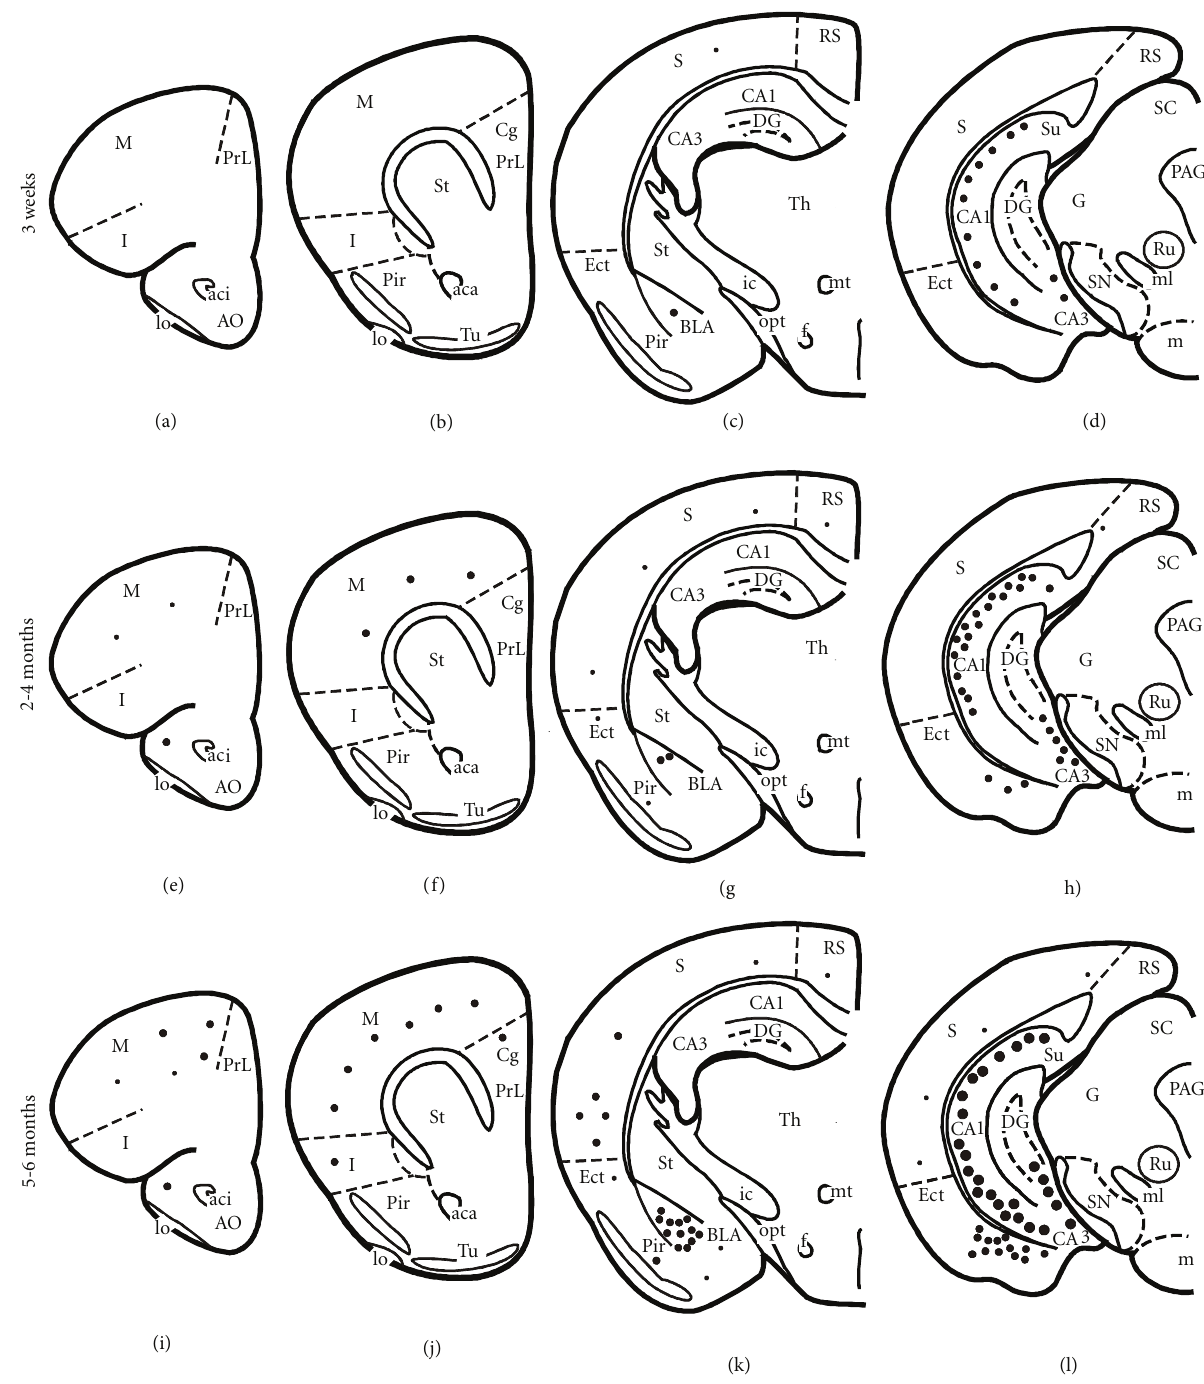
Figure 7: Schematic drawings showing the distribution of AT8-ir neurons in transcardially fixed 3-week, 3-, and 6-month-old 3xTg-AD mice. At 3 weeks, only scattered AT8-ir neurons were found in the cortex and basolateral amygdala compared to a greater number in the ventral hippocampus. Note that with increasing age, many more AT8-ir were found in the cortex, hippocampus, and amygdala . Abbreviations are the s ame as in Figure 2. Small dots = 1–5 positive neurons, medium-size dots = 10–20 positive neurons, and large dots = 100 positive